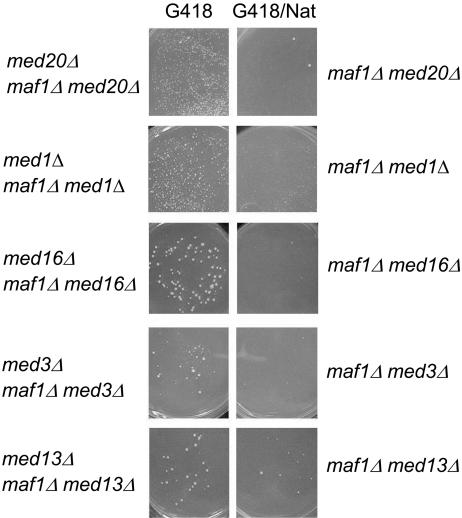
Genetic interactions between MAF1 and multiple Mediator subunits.G418-resistant Mediator subunit deletions in strain BY4741 were crossed to a clonNat-resistant maf1Δ query strain (Y6338) and genetic interactions were assessed by random spore analysis [15]. Growth at 35°C (Med20) or at 37°C (all other strains) is compared on haploid selection plates containing G418 or G418 and clonNat, which selects for strains with the indicated genotypes. In the absence of effects on strain viability, approximately equal numbers of haploid colonies are expected on the two media. Images of haploid selection plates containing no antibiotics or only clonNat (which selects for maf1Δ) have been omitted for clarity as the growth of the maf1Δ single mutant is indistinguishable from wild-type. Deletion of MED5, MED9, MED31 or cycC but not MED12 also resulted in synthetic growth defects with maf1Δ at 37°C in the random spore assay (data not shown).